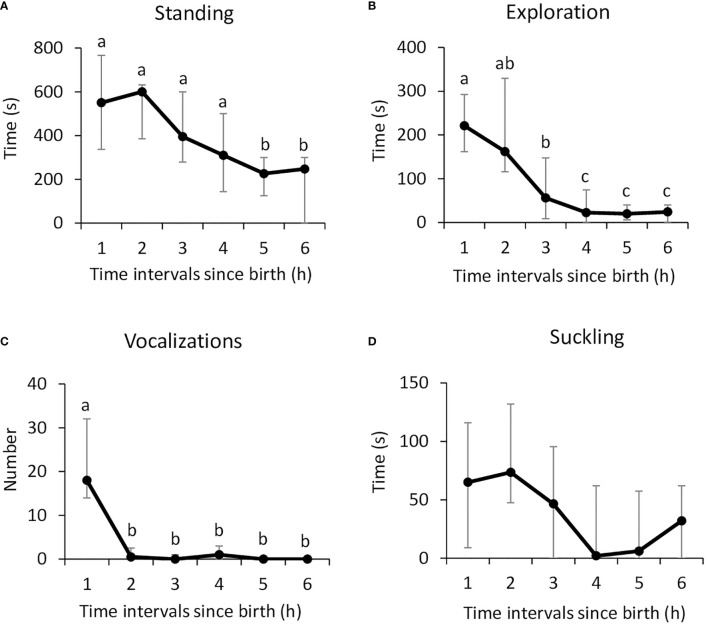
Lambs neonatal activities during the first 6 h after birth: (A) standing, (B) exploring the mother’s body (nosing, nuzzling), (C) number of vocalizations, and (D) suckling. Data (n=16) are expressed as medians and 1st and 3rd quartile. Data points with different letters are significantly different after Bonferroni correction (p=0.033).